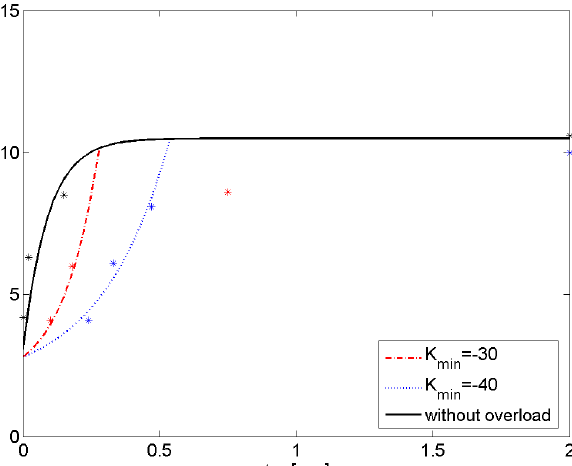
Figure 2: The R-curves for the threshold of stress intensity range at a load ratio of R=-1 for a specimen with pre-cracks generated in cyclic compression and specimens with additional compression overloads.